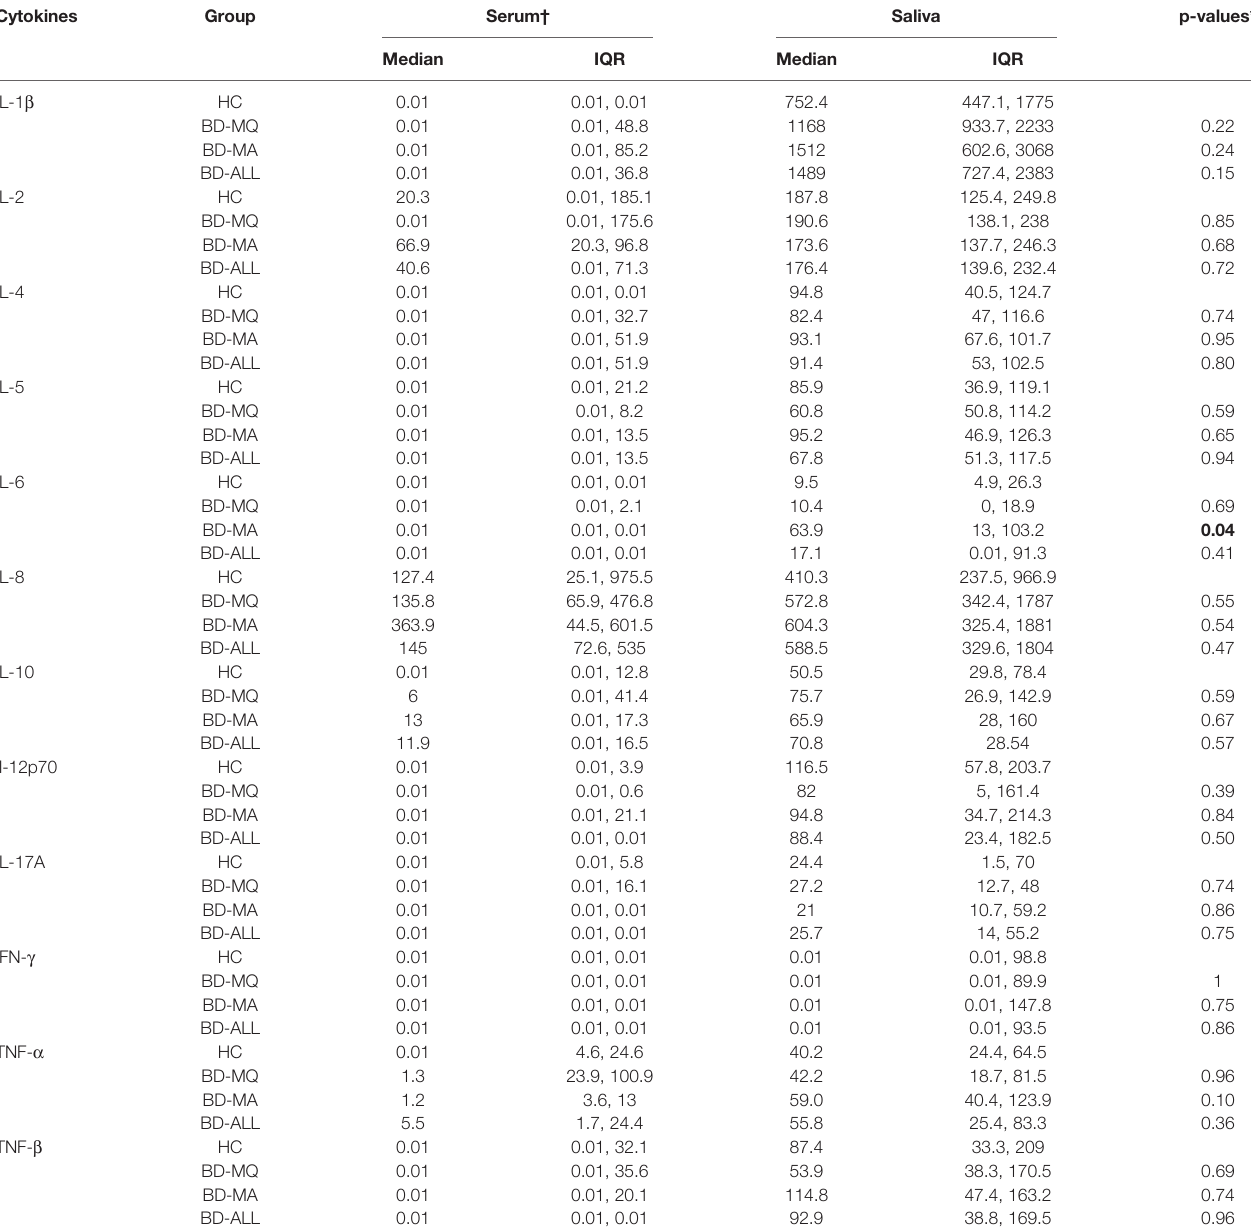
TABLE 3 | Concentrations of cytokines in serum and saliva of patients presenting with oral ulceration (Mouth Active (BD-MA)) or without (Mouth Quiet (BD-MQ)) oral ulceration involvement. Cytokines Group Serum † Saliva p-values*